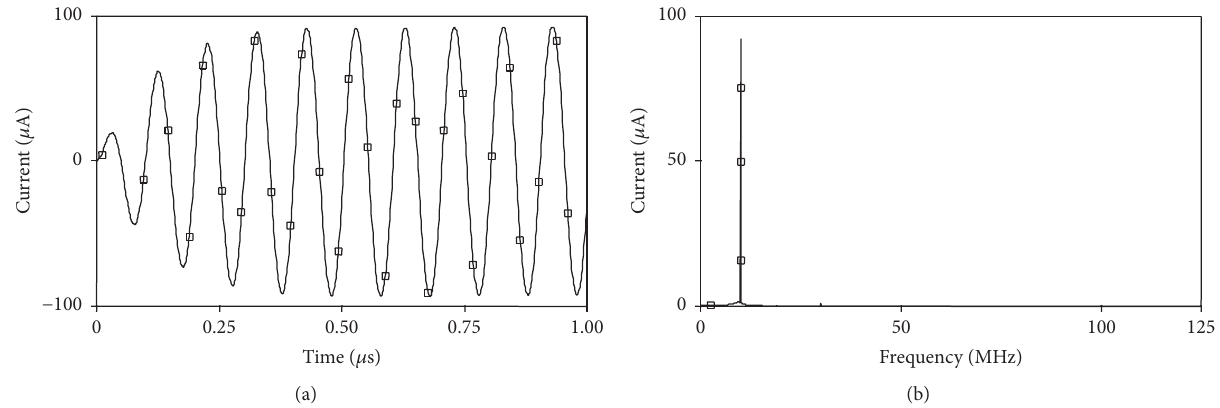
Figure 13: (a) The current output transient signal and (b) its frequency spectrum.